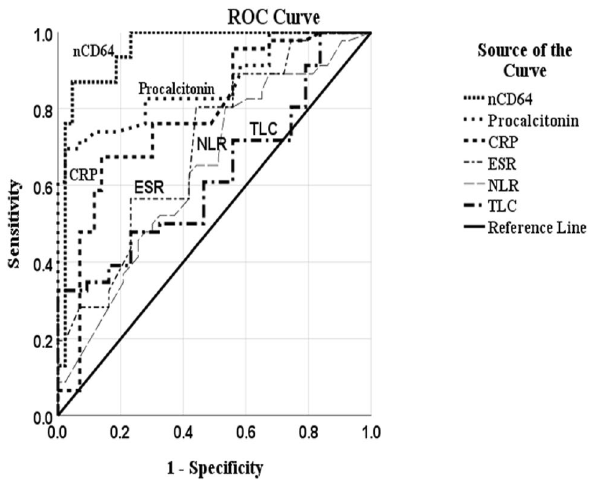
Figure 3. Receiver operating characteristic curves of neutrophil CD64 expression, serum procalcitonin, Neutrophil:lymphocyte ratio, C-reactive protein, erythrocyte sedimentation rate and total leukocyte count in patients of severe alcoholic hepatitis with infection and non-infection